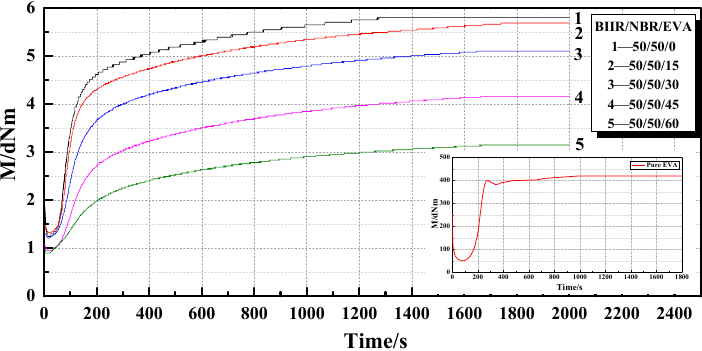
Figure 12 . Curves of vulcanization characteristics for NBR/BIIR/EVA with various blend ratios. Figure 12. Curves of vulcanization characteristics for NBR / BIIR / EVA with various blend